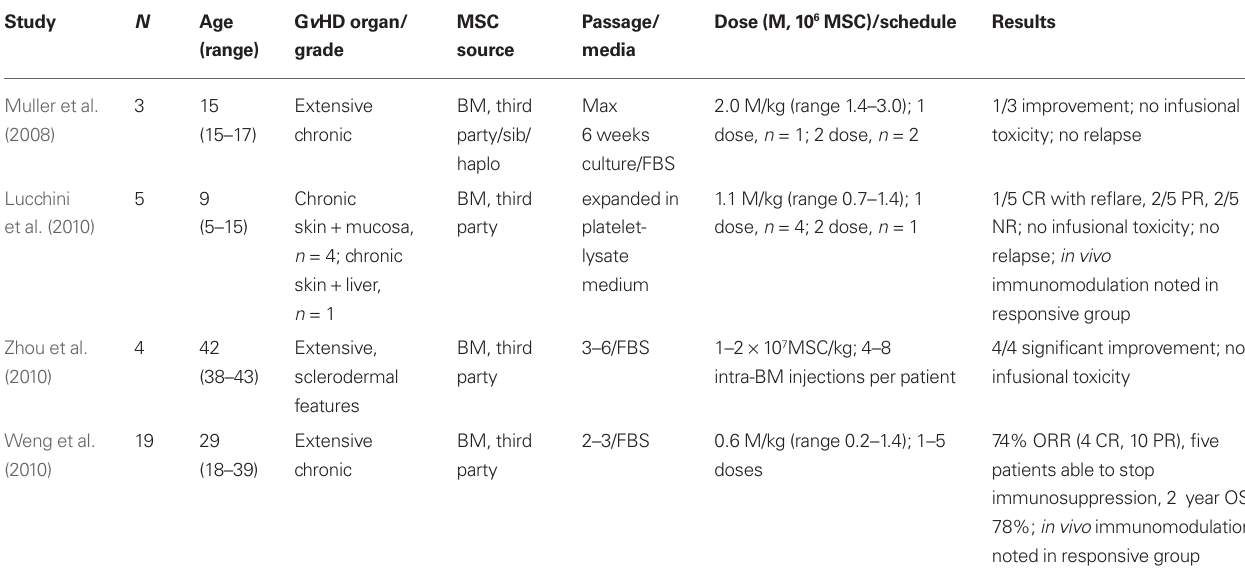
Table 3 | Results of clinical trails utilizing MSC for chronic G v